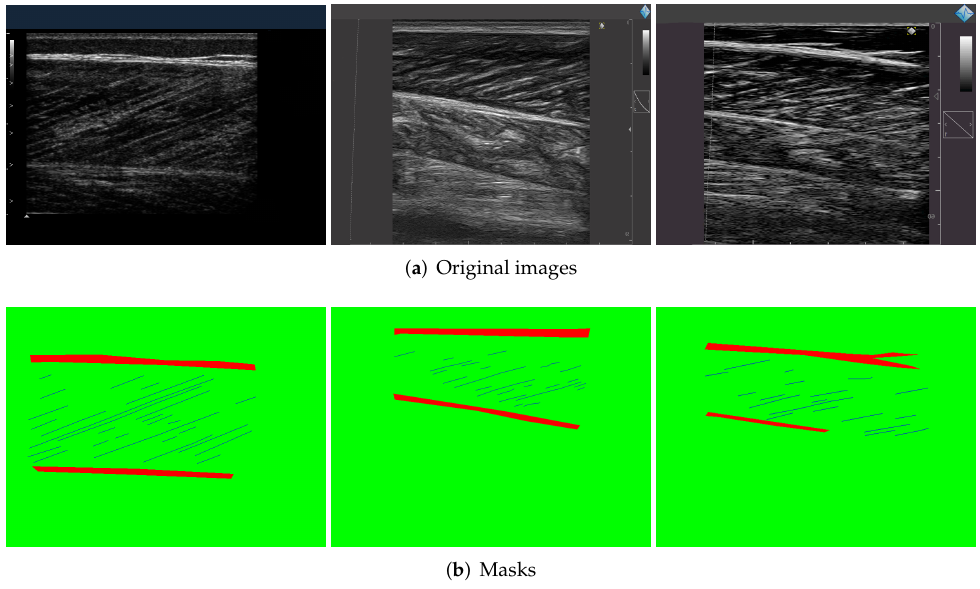
Figure 4. Samples from the training dataset. ( a ) Some original ultrasound images collected from multiple subjects. ( b ) The ground truth marked by the experimenters using Fiji